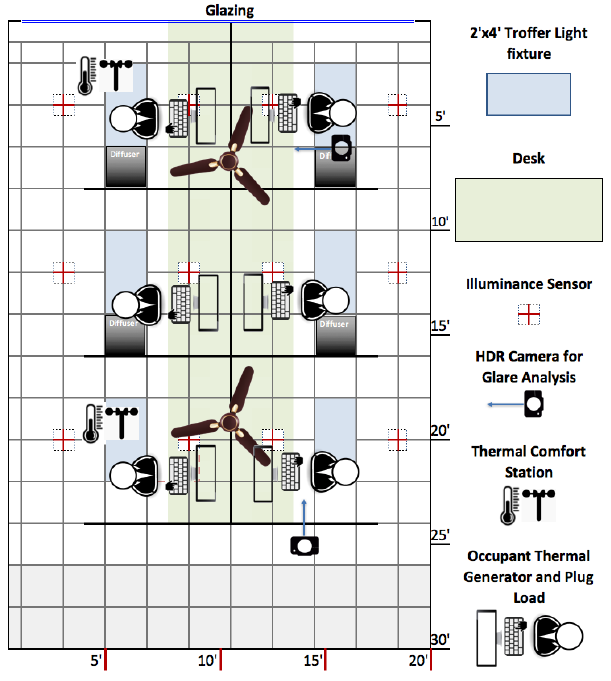
Figure 1. Test cell layout.